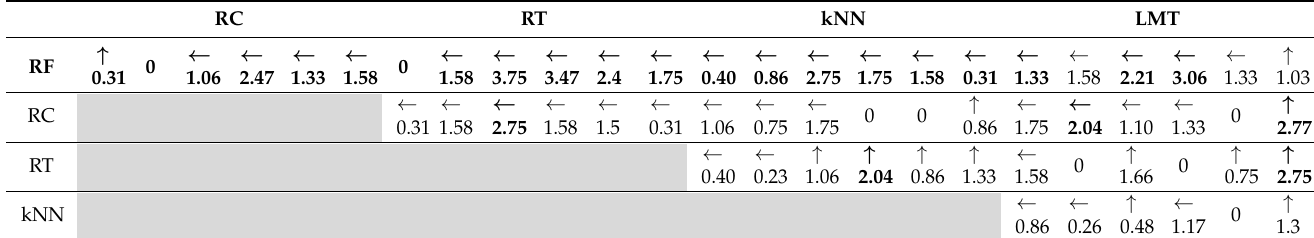
Table A2. Z scores of ML algorithms on cancer stage classification. (Illustrations by the authors).